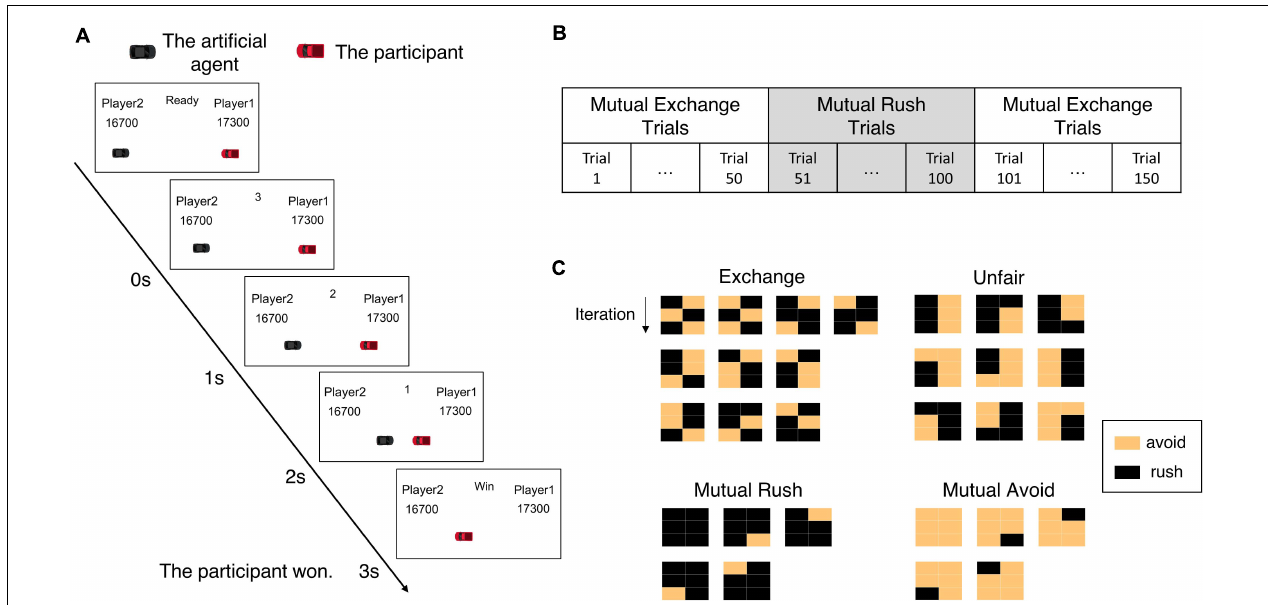
FIGURE 2 | The experimental paradigm. (A) The procedure of the iterative chicken game. In each iteration, two cars appear on the screen and approach toward each other for 3 s. One of the cars is controlled by the artificial agent and the other by an experiment participant. The game result and payoffs are displayed at the end of the iteration. The displayed game result indicates whether the participant wins or loses. In this example, the artificial agent avoided but the participant did not, so the participant won. (B) The experiment contains a total of 150 iterations among which the artificial agent plays in a direction to mutually exchange rewards with the opponent in the first 50 iterations, then in another direction to keep rushing in the second 50 iterations, and returning to the same direction as the first in the last 50 iterations. (C) Bilateral joint action patterns from both the participant and the artificial agent are analyzed in the window of 3 consecutive iterations. Here are shown possible bilateral action patterns belonging to each of the four behavioral patterns: mutual rush, mutual avoid, unfair, and mutual exchange. Each matrix indicates a bilateral action pattern; a column stands for a player and a row for an iteration. The yellow box represents the behavior of avoidance and the black one means